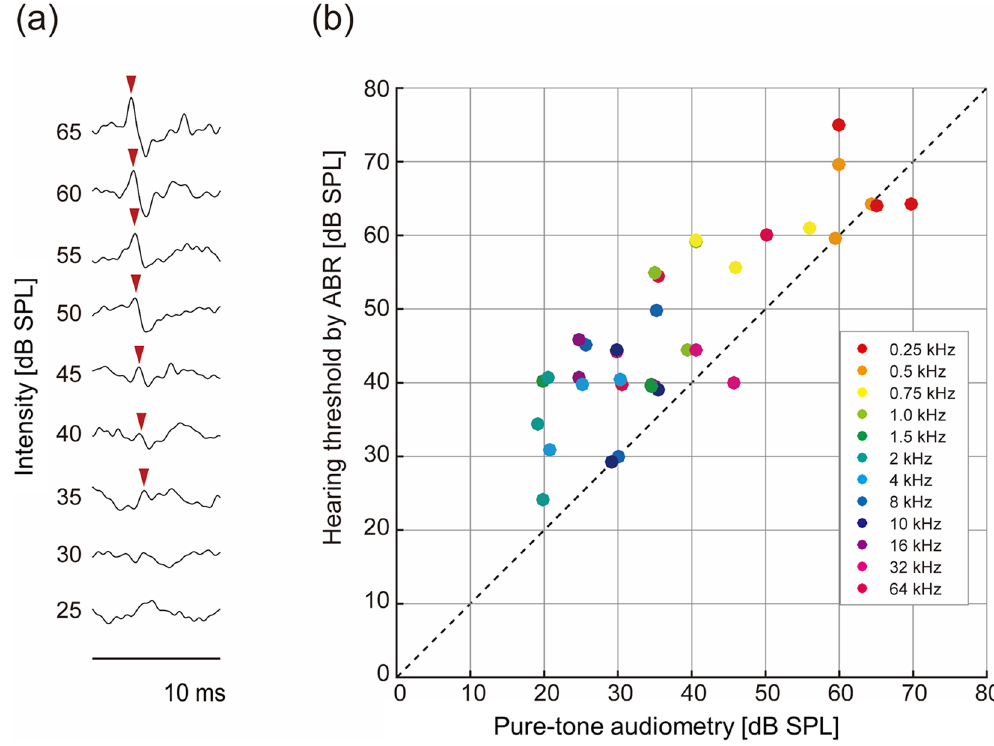
Figure 3. The ABR-based audiogram in relation to the pure-tone audiogram. ( a ) A representative ABR waveform. The peak values (red arrows) were used to determine an ABR threshold. ( b ) The values of the ABR- based audiogram plotted against the values of the pure-tone